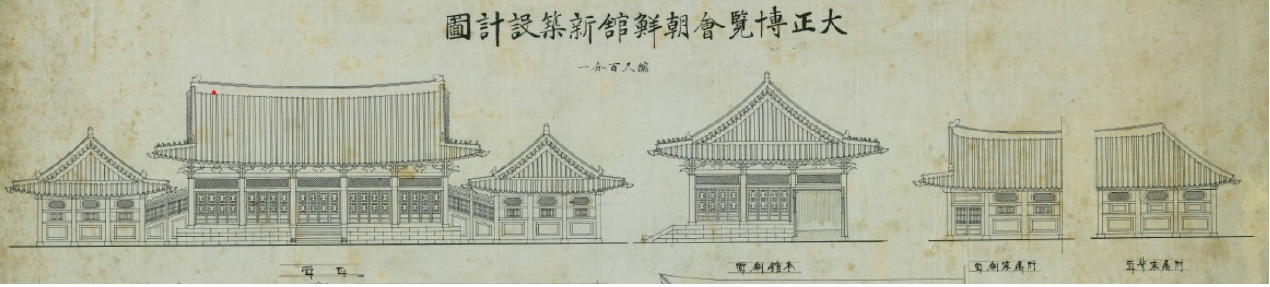
Figure 25. Elevation of the Korea Pavilion at the 1914 Tokyo Taisho Expo (Plans E and F are section drawings of the same building). (Source: National Archives of Korea) [5].